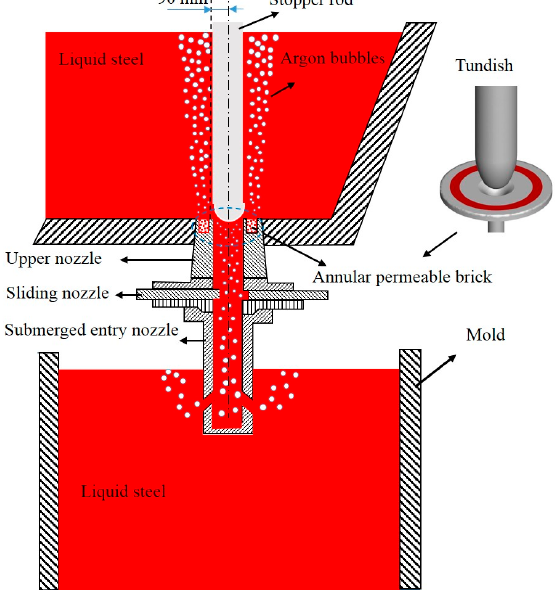
Figure 2. Schematic diagram of annular argon blowing at the tundish upper nozzle.